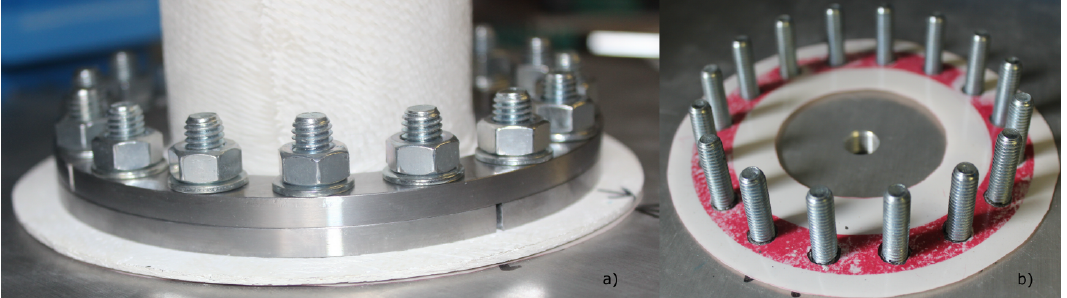
Figure 10. The revised flange connection ( a ) creates a homogeneous force distribution, which is visible through the closed red ring imprint of the indicator film ( b